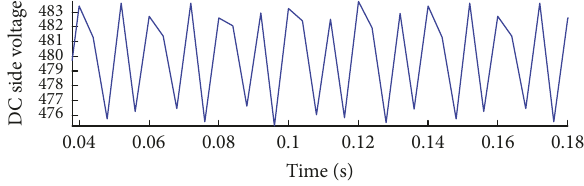
Figure 7: Voltage of DC side capacitor ( 𝑉 dc ).